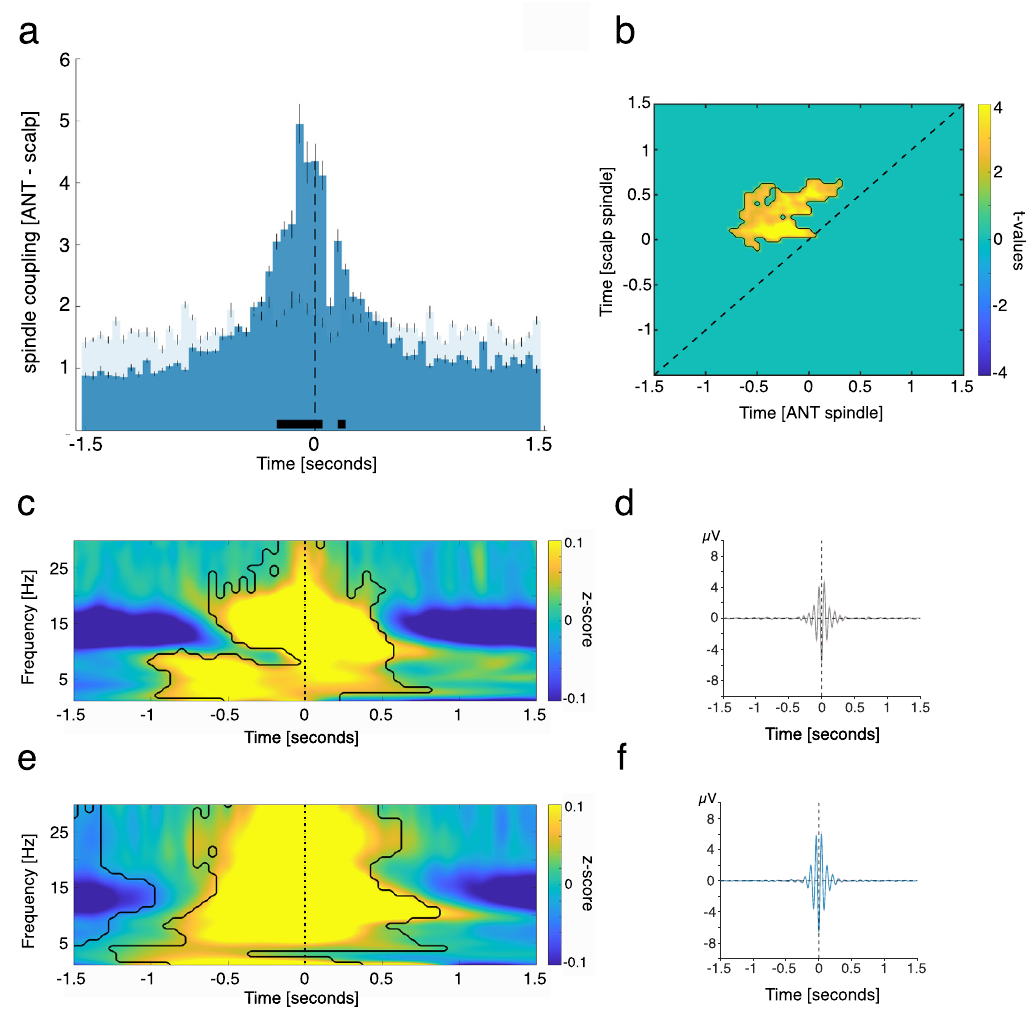
Fig.4|ANTspindlesleadneocorticalspindles.a OccurrenceprobabilitiesofANT spindle peaks relative to neocortical spindle peaks (maximal negative amplitude, time = 0; dashed line; bin size = 50ms), indicating that ANT spindles precede neocorticalspindles.Thesolidblacklineindicatessigni fi cantdifferences,resulting from comparison with spindle-free control events (dependent-samples t -test, two- sided, positive clusters from − 0.25 to − 0.05s, p <0.005 & 0.15 to 0.2s, p =0.019; time of peak: − 0.1 s; corrected for multiple comparisons across time). b Power – power correlations in the sleep spindle band for paired spindle events (locked to neocortical spindle peaks), contrasted against event-free correlation maps. The contour lines indicate the cluster (dependent-samples t -test, two-sided, p =0.004, cluster corrected across time), depicting that ANT spindle power